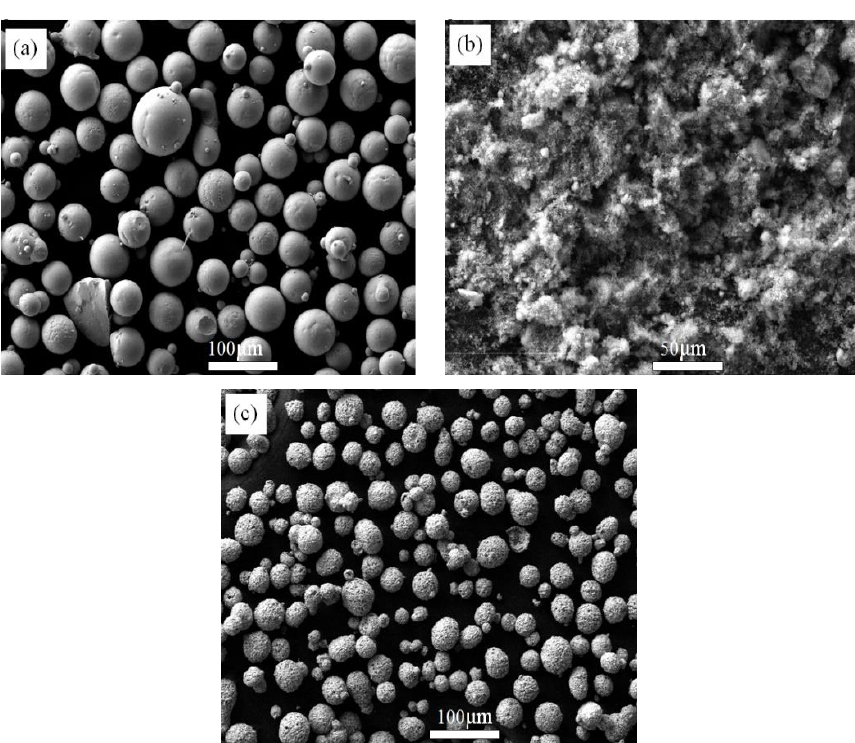
Figure 2. Microscan of raw material, ( a ) Ni60, ( b ) TiO 2 , ( c ) WC-12Co.